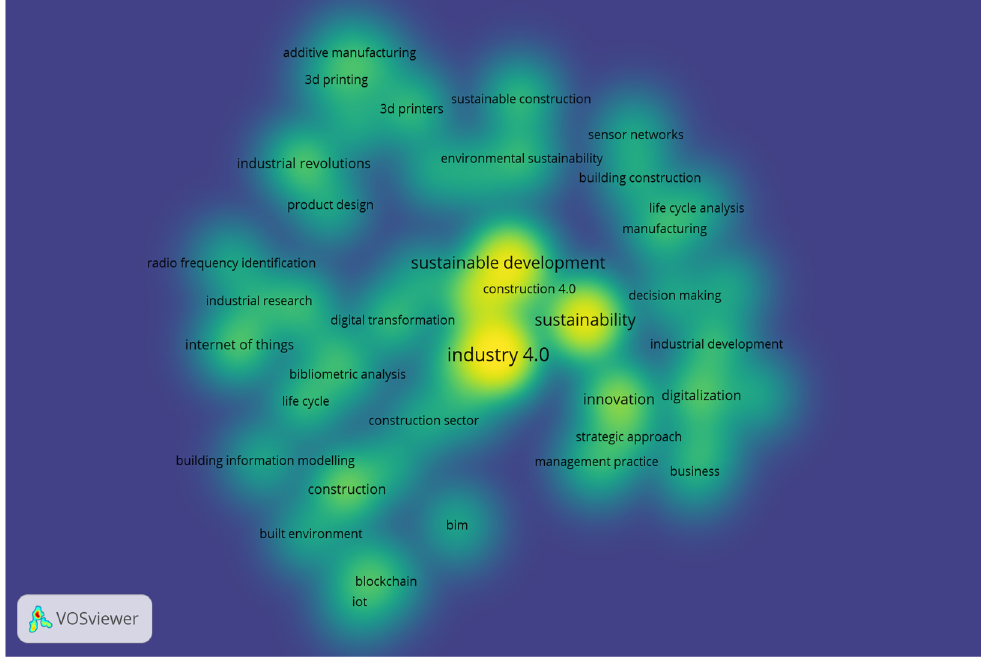
Figure 4. Keywords Co-occurrence Density map. Source: Own elaboration supported by VOSviewer, 2021.